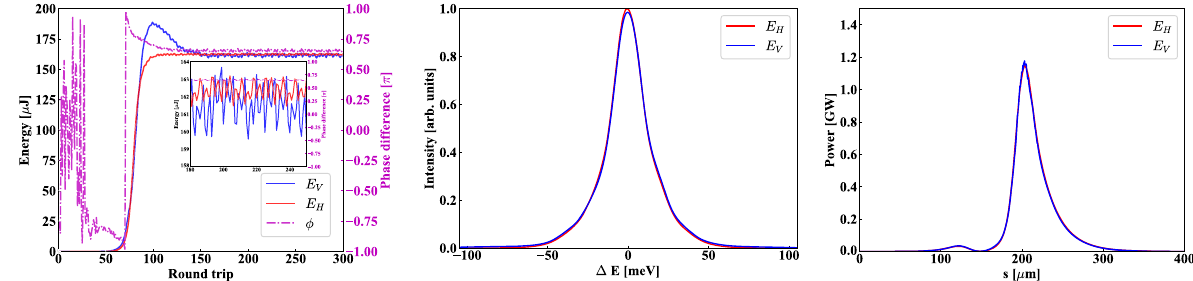
FIG. 3. The pulse energy evaluation (left), the spectrum of the radiation (center), and the temporal power profile (right) are shown. The phase difference (purple line) between the two linearly polarized components is presented in the left plot. The total energy is about 325 μ J, the spectrum has an FWHM width of 25 meV, and the pulse has a peak power of 1.2 GW.